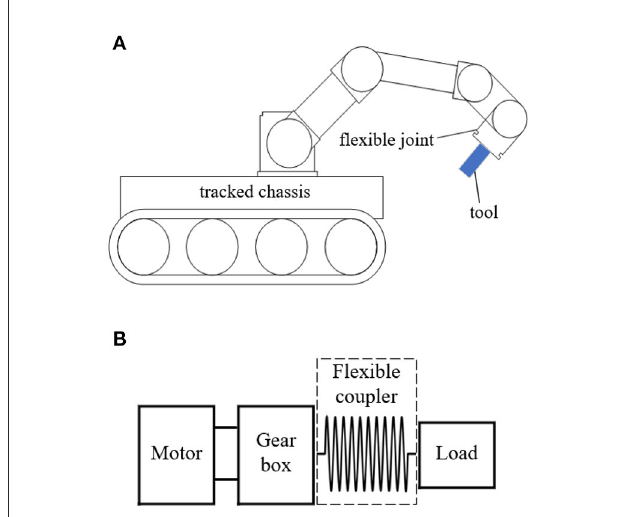
FIGURE1 The schematic diagram of the inspection robot and the flexible joint. (A) Schematic diagram of the inspection robot. (B) Schematic diagram of the flexible